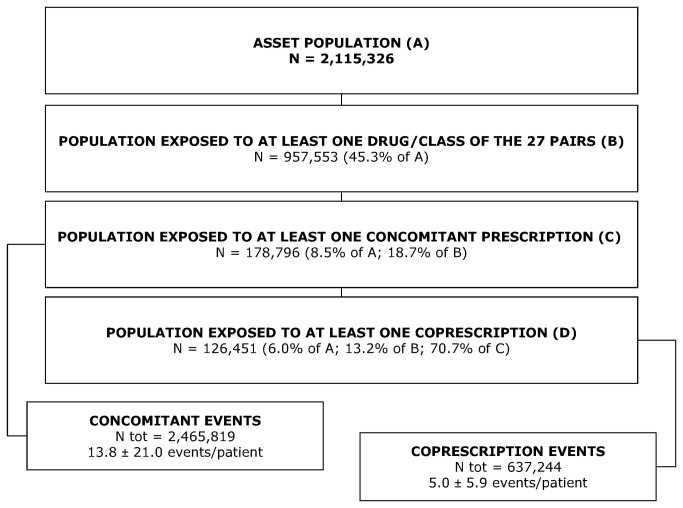
Number and proportion of patients involved in pDDIs.